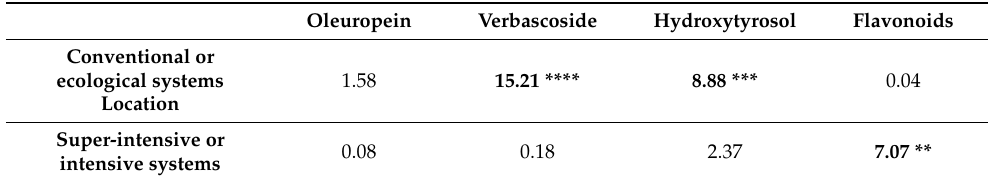
Table 2. Multifactorial analysis of different agronomic conditions on the phenolic compounds of olive leaves. Oleuropein Verbascoside Hydroxytyrosol Flavonoids Conventional or ecological